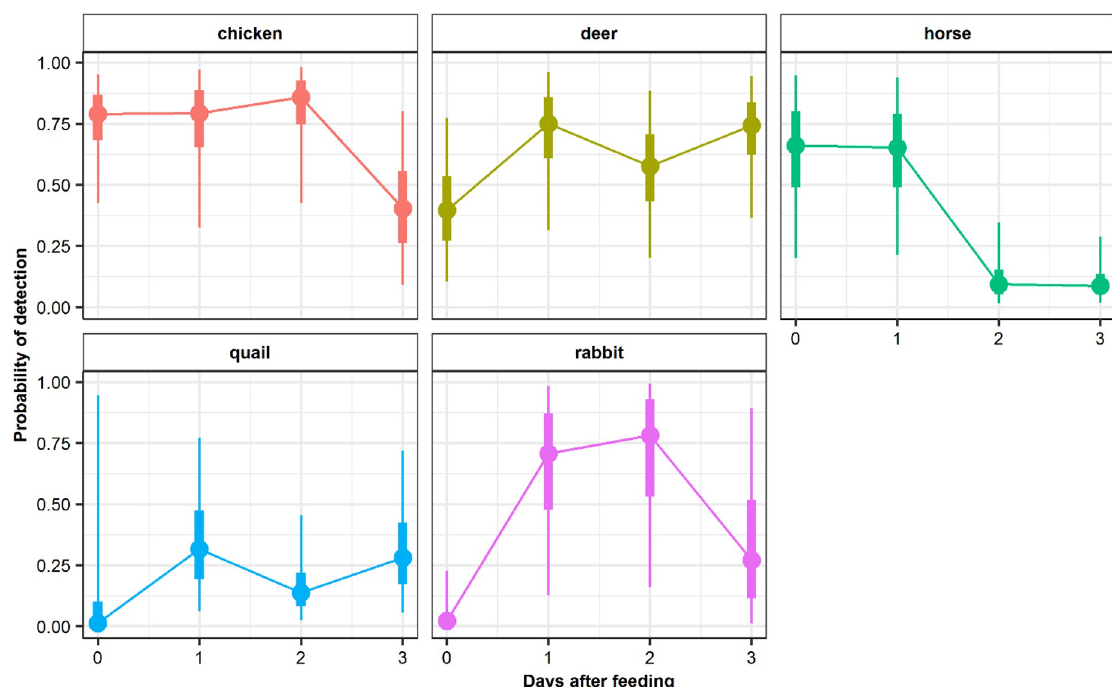
Fig 2. Estimates of mean detection probability of each prey species in scat samples relative to time since feeding. The bold and thin lines represent the 50% and 95% credible intervals around the means.